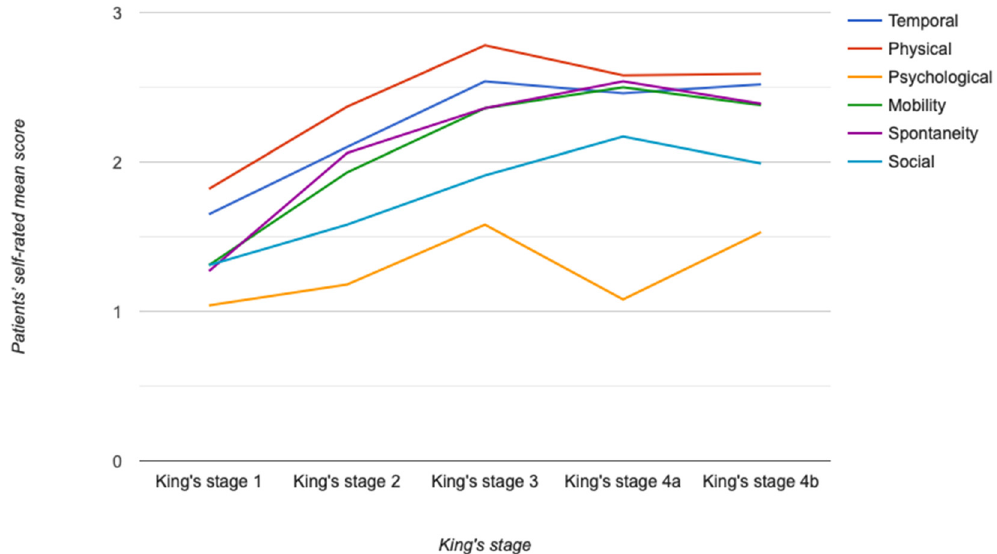
Figure 2. Chart showing the association of ALS with activities of daily living. Association between King’s stages (shown on the x -axis) and activities of daily living in different dimensions (with answers ranging from 0 = no impact to 3 = severe impact, shown on the y -axis). The temporal category relates to the patient’s self-reported impact of ALS on the time taken to do usual activities, as well as the impact on their free-time. Abbreviations: ALS, amyotrophic lateral sclerosis; King’s stage, King’s College Staging System.